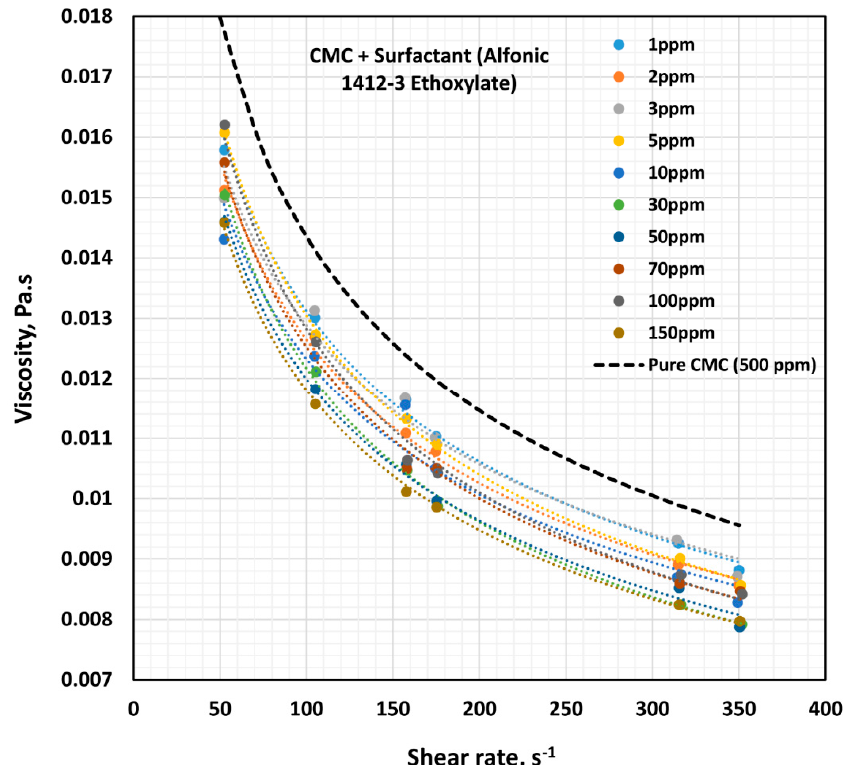
Figure 11. Effect of non-ionic surfactant (Alfonic 1412-3 Ethoxylate) on the viscosity versus shear rate behavior of solutions of mixtures of anionic polymer, CMC, and non-ionic surfactant, Alfonic 1412-3 Ethoxylate, at a fixed polymer concentration of 500 ppm.